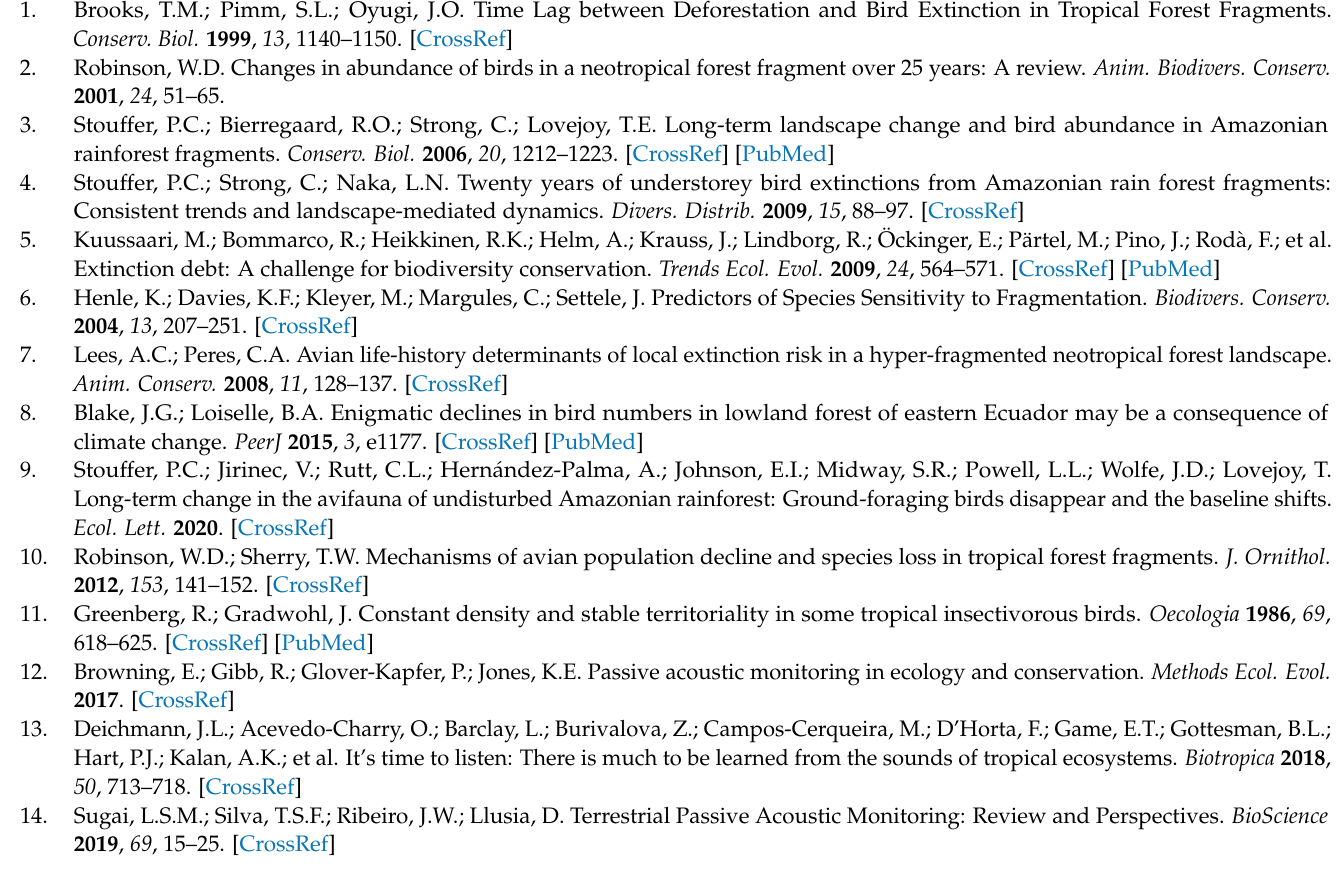
Supplementary Materials: The following are available online at https://www.mdpi.com/1424-281 8/13/2/50/s1: Table S1: List of the 50 bird species selected for occupancy analyses, Table S2: List of occupancy models used in the analyses, Table S3: Model selection results for each species, Table S4: Estimated detectability for each species per Era, Table S5: Estimated occupancy for each species per Era and Forest Age, Table S6: Model average effects for Era, Elevation and Forest Age variables on occu-pancy and detection